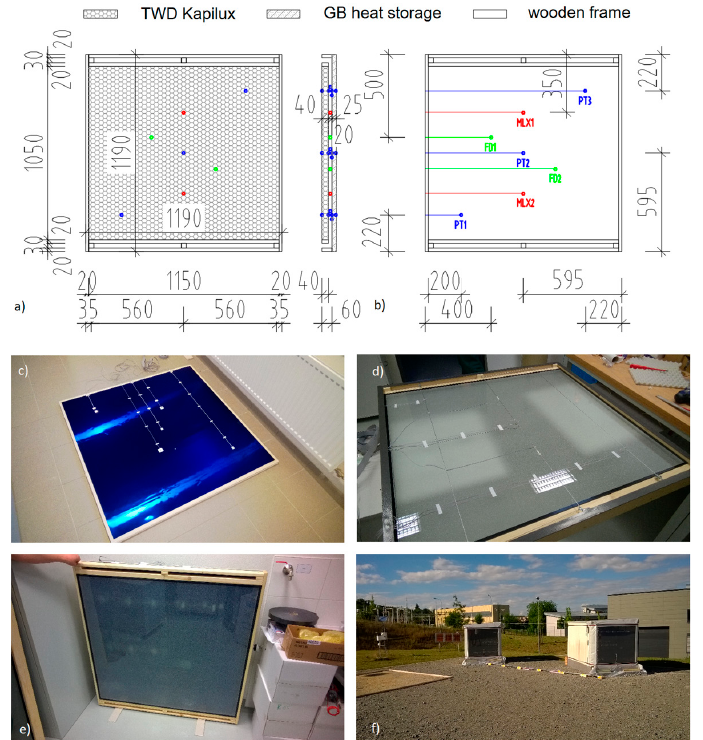
Figure 10. Full-scale outdoor measurements ( a ) Test setup and its geometrical compositions; ( b ) Measurements temperature and solar radiation points; ( c ) Selective absorber part; ( d ) Transparent insulation material TWD Kapilux; ( e ) Whole sample component and final test prototype; ( f ) Outdoor